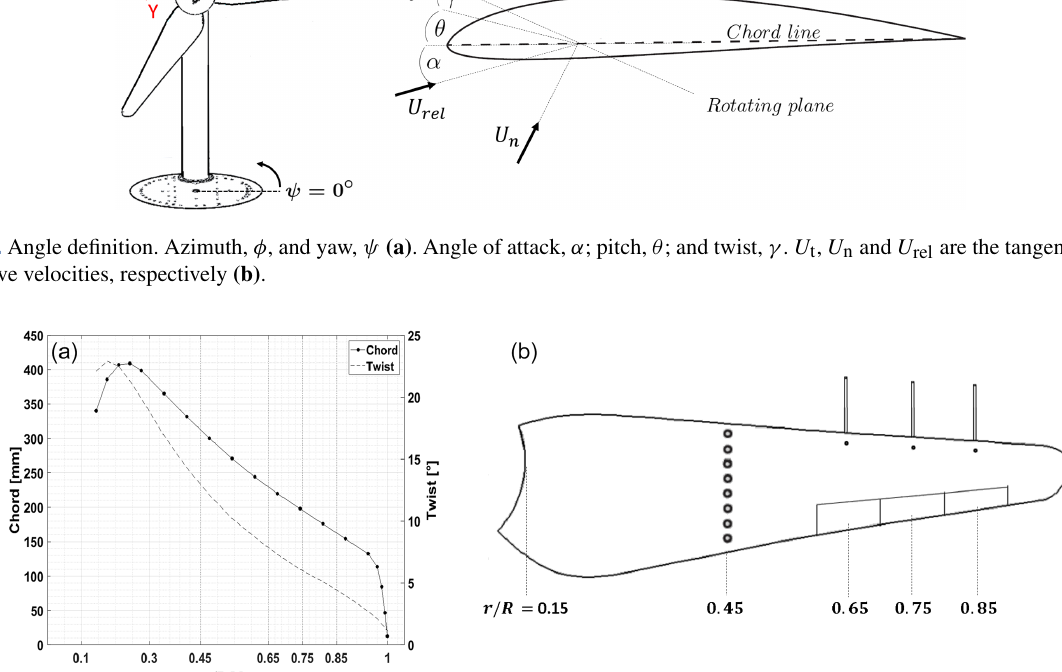
9188) measurement systems were synchronized and